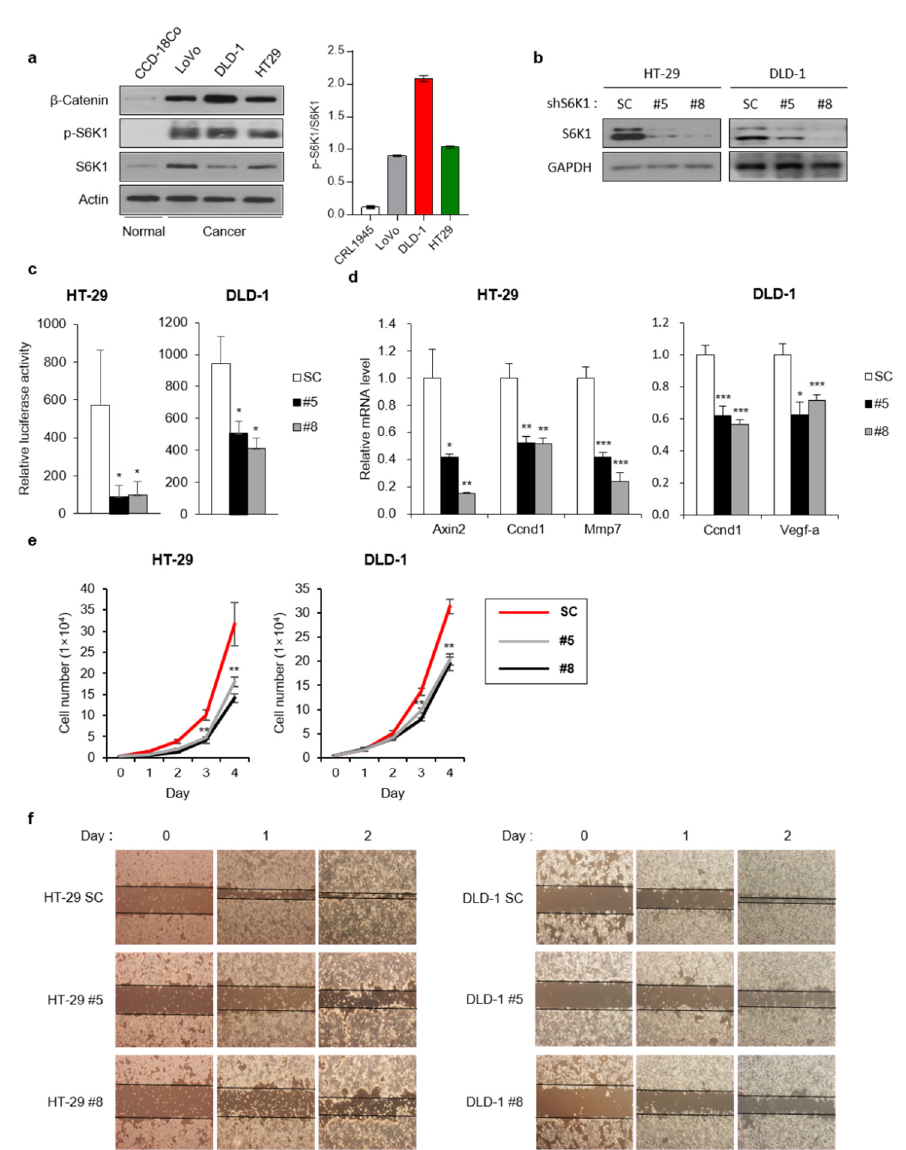
Figure 6. Effects of S6K1 deficiency in colon cancer cell lines. ( a ) S6K1 is aberrantly activated in colon cancer cell lines. Immunoblotting was performed using total protein extracts from CCD-18Co (normal colon cells), LoVo, DLD-1, and HT-29 (colon cancer cells) and specific antibodies as indicated. ( b ) HT-29 and DLD-1 S6K1-knockdown cell lines. Immunoblotting was performed using these S6K1-knockdown two colorectal cancer cell lines and antibodies as indicated. ( c ) Reduced S6K1 levels suppressed TOPFlash luciferase reporter activity. TOPFlash luciferase reporter assay was performed in HT-29 and DLD-1 S6K1-knockdown cell lines. ( d ) S6K1 knockdown suppresses the expression of Wnt target genes in colon cancer cells. qRT-PCR was performed in HT-29 and DLD-1 S6K1-knockdown cell lines. ( e ) Loss of S6K1 inhibits cell proliferation in HT-29 and DLD-1 colon cancer cells. Cell proliferation assay was performed in HT-29 and DLD-1 S6K1-knockdown cell lines using an automated cell counter as indicated time points. ( f ) Loss of S6K1 inhibits cell migration in HT-29 and DLD-1 colon cancer cells. Wound-healing assay was performed using HT-29 and DLD-1 S6K1-knockdown cells. Data are represented as the mean ± SEM for n = 3. * p < 0.05; ** p < 0.01; *** p <